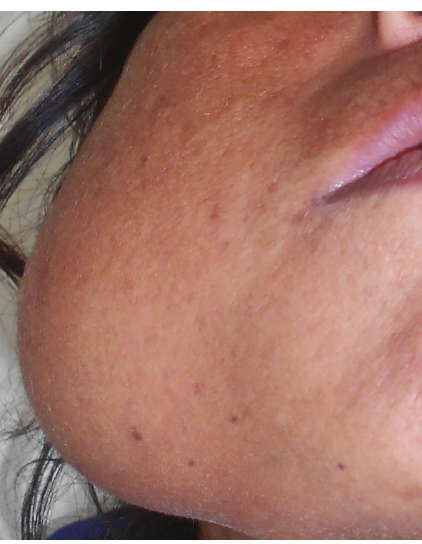
Figure 1: Frontal view of the patient showing extraoral swelling in the right lower mandibular region.